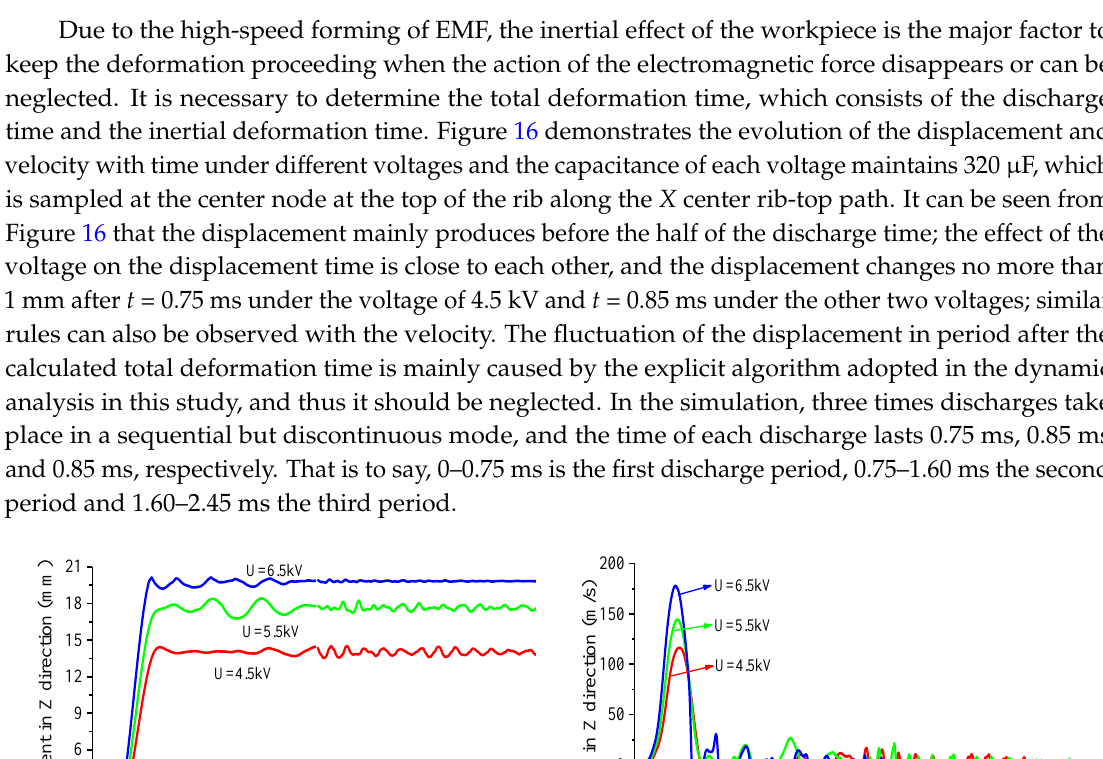
Figure 15. Experimental and simulated coil current data (( a ) U = 9.9 kV, C = 80 μF; and ( b ) U = 12 kV, C = 80 μF).